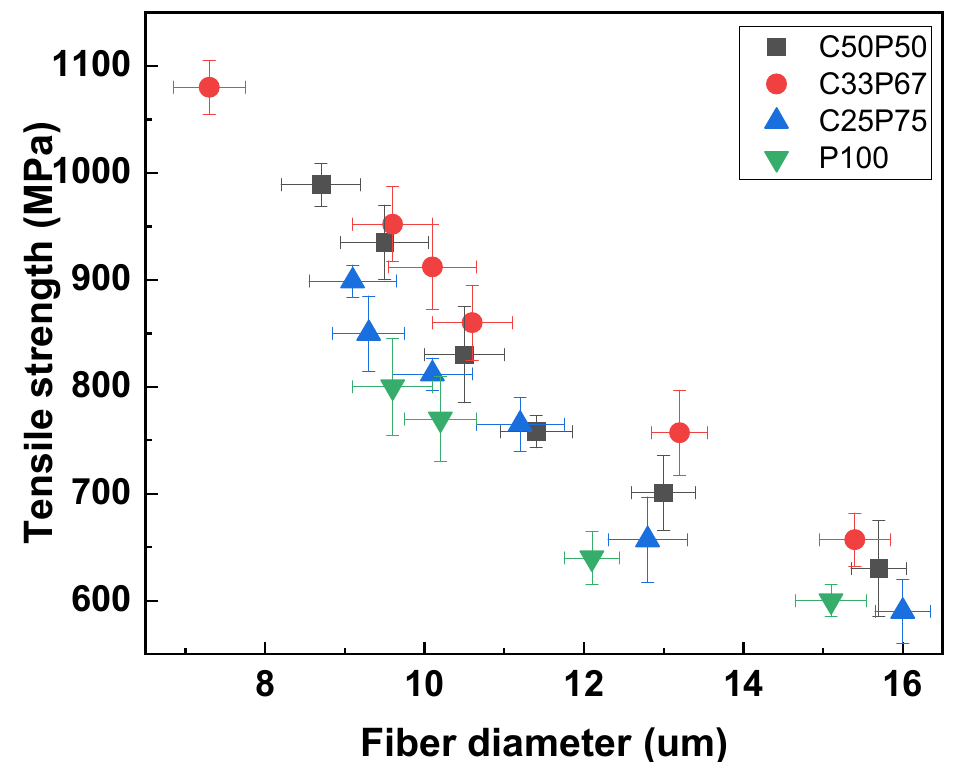
Figure 7. Tensile strength of isotropic carbon fibers prepared by co-carbonization of purified coal tar pitch and PFO in various ratios. Table 5. Mechanical properties of isotropic pitch-based carbon fibers prepared by various methods and raw materials. Isotropic